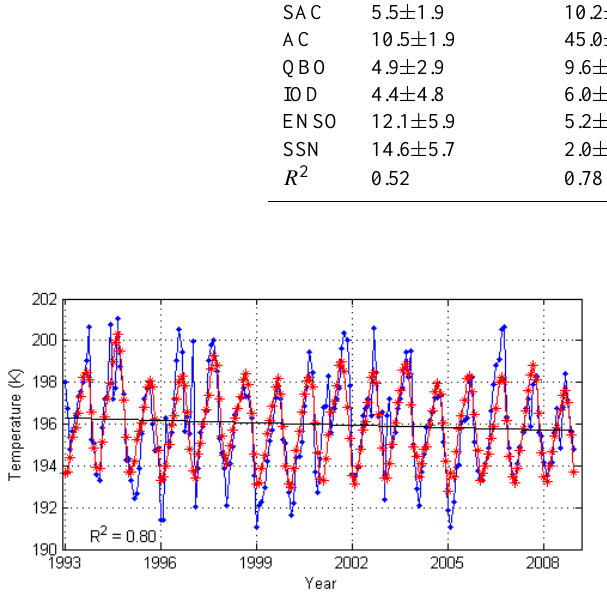
Figure 3 : Time evolution of monthly temperature values as observed over Reunion Island at CPT from January 1993 to December 2008 (blue line), the superimposed red star line represents CPT values as simulated by Trend-Run regression model, while the straight black line illustrates the obtained temperature trend at CPT. The corresponding coefficient of determination R 2 is shown, R 2 = 0.80.